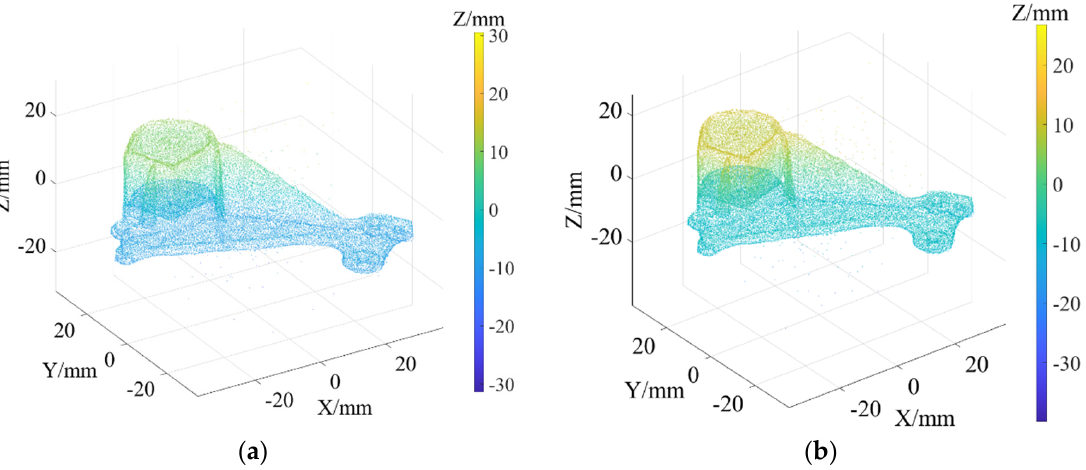
Figure 5. Denoising results of APSS under different noise intensities: ( a ) APSS (𝜎 = 0.2) ; ( b ) APSS (𝜎 = 0.4) .